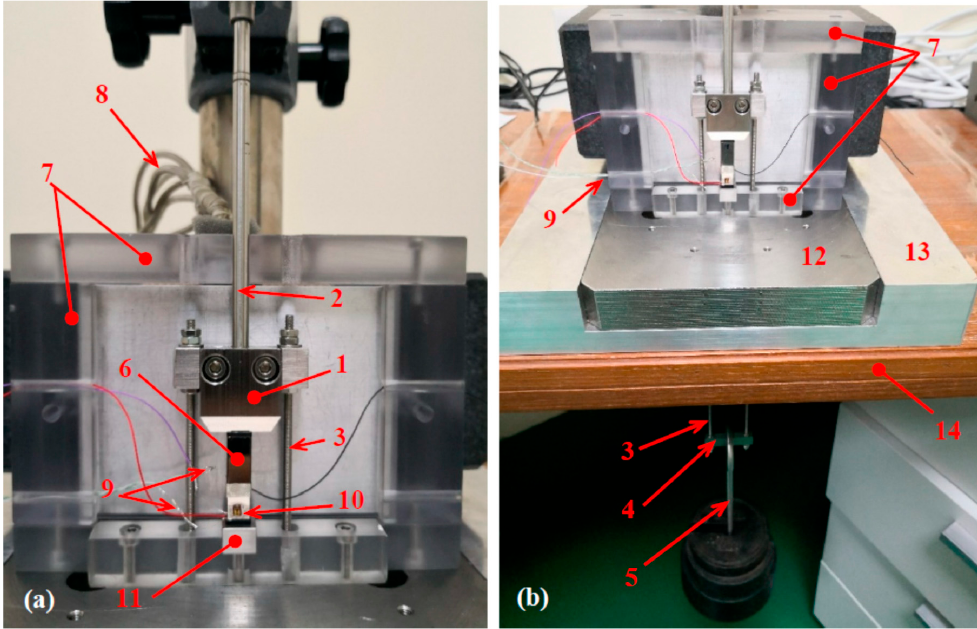
Figure 3. Experiment setup used: ( a ) single crystal stake actuator sample (6) bonded with a strain gage (10) and loaded via the loading mechanism (1, 2, 3, and 4); ( b ) application of compressive stress via adding weights onto the weight pan (5). The structure made of translucent polycarbonate is part